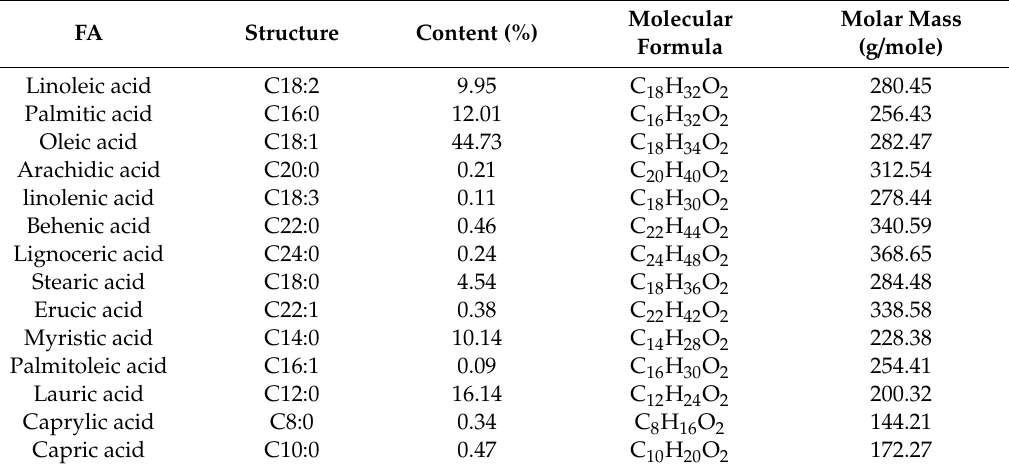
Table 5. Fatty acid (FA) profile of the